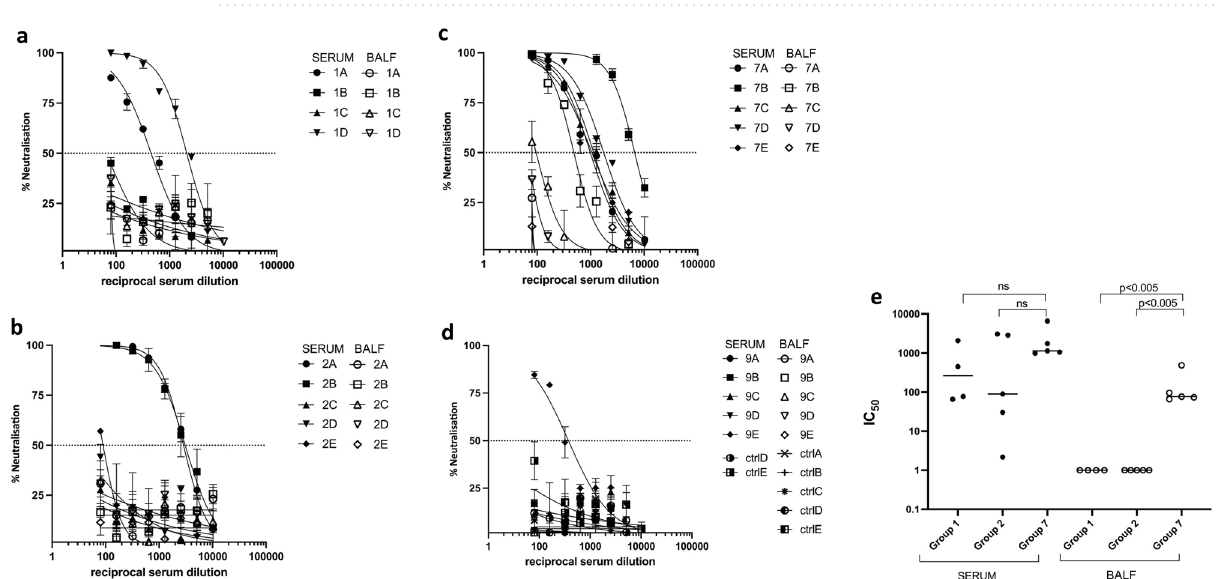
Figure 3. Monovalent SARS-CoV-2 RBD vaccines induce SARS-CoV-2 pseudovirus (Wuhan-Hu-1) neutralizing antibodies in serum and BALF. Mice were prime-boost immunized intranasally (d0, d21) with non- targeted (nt) RBD, strain Wuhan-Hu-1 (group #1), or M-cell targeted RBD (RBD-cCPE, group #7), and sera and BALF obtained on day 28, 1 week after the boost, diluted in tenfold steps, and assayed for neutralization of SARS-CoV-2 pseudoviruses (PV). The spike protein sequence was derived from SARS-CoV-2 strain Wuhan-Hu-1. ( a ) (mice group #1): Serum and BALF, intranasal prime-boost immunization with nt RBD plus Riboxxim. ( b ) (group #2): Serum and BALF, subcutaneous prime-intranasal boost immunization with nt RBD plus Riboxxim. ( c ) (group #7): Serum and BALF, intranasal prime-boost immunization with M-cell targeted RBD (RBD-cCPE) plus Riboxxim. ( d ) (group #9): Serum and BALF, control mice (ctrlA-E). ( e ) In BALF, IC50 of neutralizing antibody was significantly higher for group #7 compared to group #2 or #3, respectively ( p < 0.005, two-sided Mann–Whitney U test), but not in